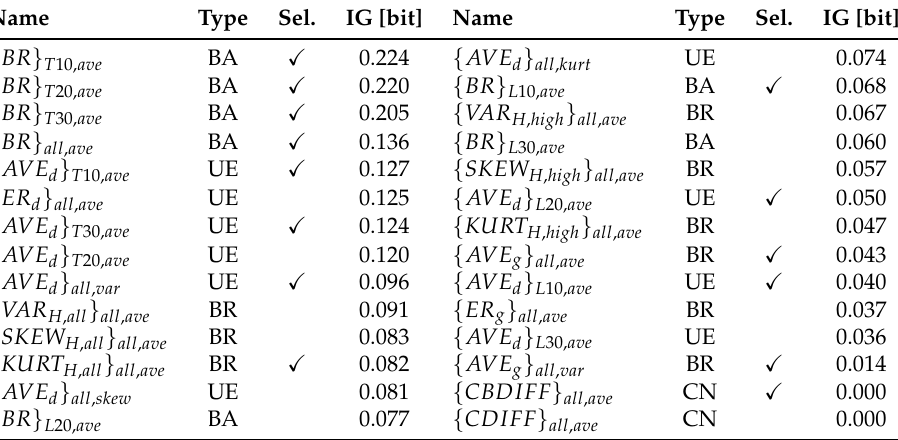
Table 8. List of the features for a linkage line (a check mark (cid:88) indicates that the feature was selected).